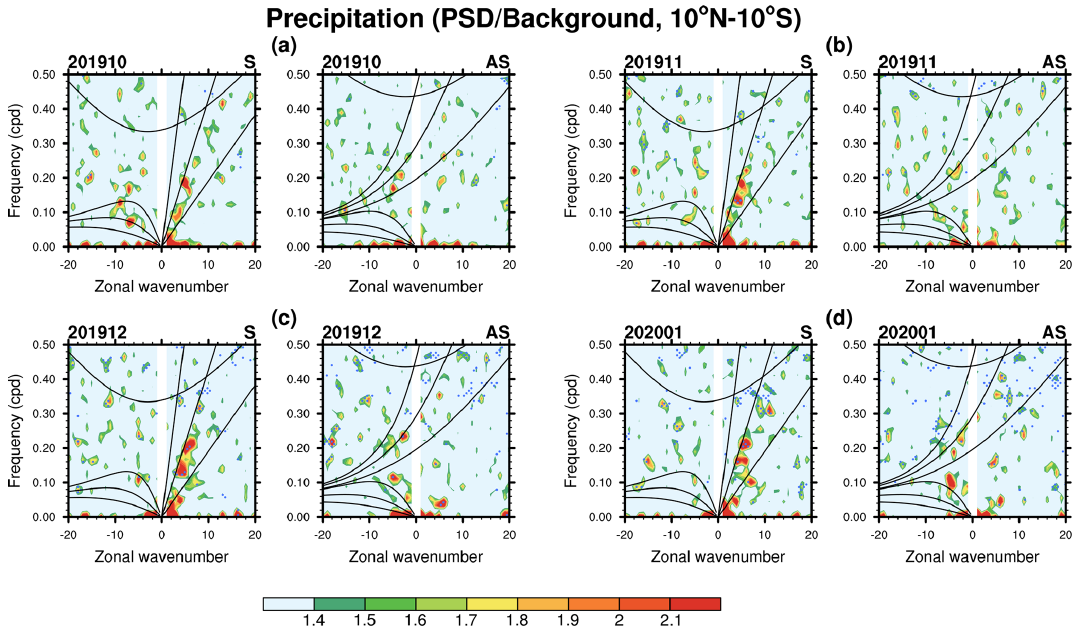
Figure 9. Zonal wavenumber–frequency spectra of the MERRA-2 precipitation divided by that of the background spectrum for (a, c) the symmetric and (b, d) antisymmetric components (separately) averaged between 10 ◦ N and 10 ◦ S for (a) October 2019, (b) November 2019, (c) December 2019, and (d) January 2020. The value larger than 1.4 is statistically significant at the 95% confidence level using a t test. The blue stipples represent power spectral density (PSD) greater than the climatology by more than its standard deviation. The theoretical dispersion relation for each equatorial wave mode is denoted by a black solid line for the equivalent depths of h = 8, 40, and 240m, but for the IG waves only the h = 8m line is